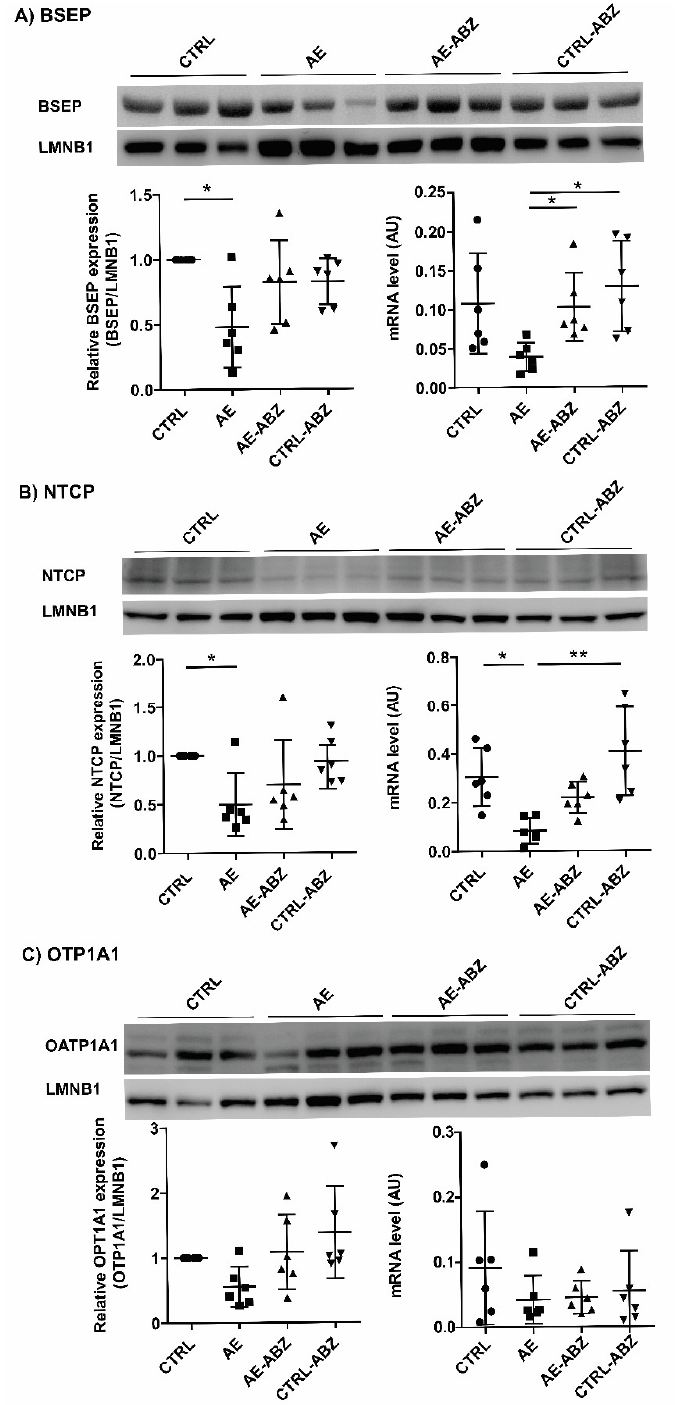
Figure 4. Hepatic mRNA and protein expression levels of BSEP, NTCP, and OATP1A1 in the four treatment groups. Western blot and semi-quantitative analysis by densitometry of protein levels of transporters BSEP ( A ), NTCP ( B ), and OATP1A1 ( C ) in the liver tissues of non-infected control (CTRL, n = 6), E. multilocularis -infected (AE, n = 6), E. multilocularis -infected and ABZ-treated (AE-ABZ, n = 6), and non-infected and ABZ-treated control mice (CTRL-ABZ, n = 6). One representative blot (of two) containing samples from three different mice is shown in the top panel. Densitometry results represent data from the two blots on samples from six mice (mean ± SD), normalized to lamin B1 (LMNB1) control, and with CTRL set as 1. * p < 0.05 and ** p < 0.01. For the assessment of protein expression using western blot analysis, antibodies suit- able for BSEP, NTCP, and OATP1A1 were available. Protein expression was analyzed by